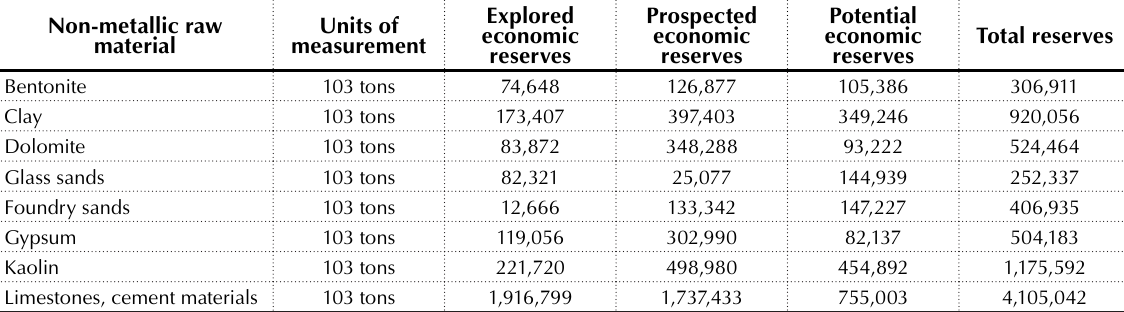
Source: Česká geologická služba